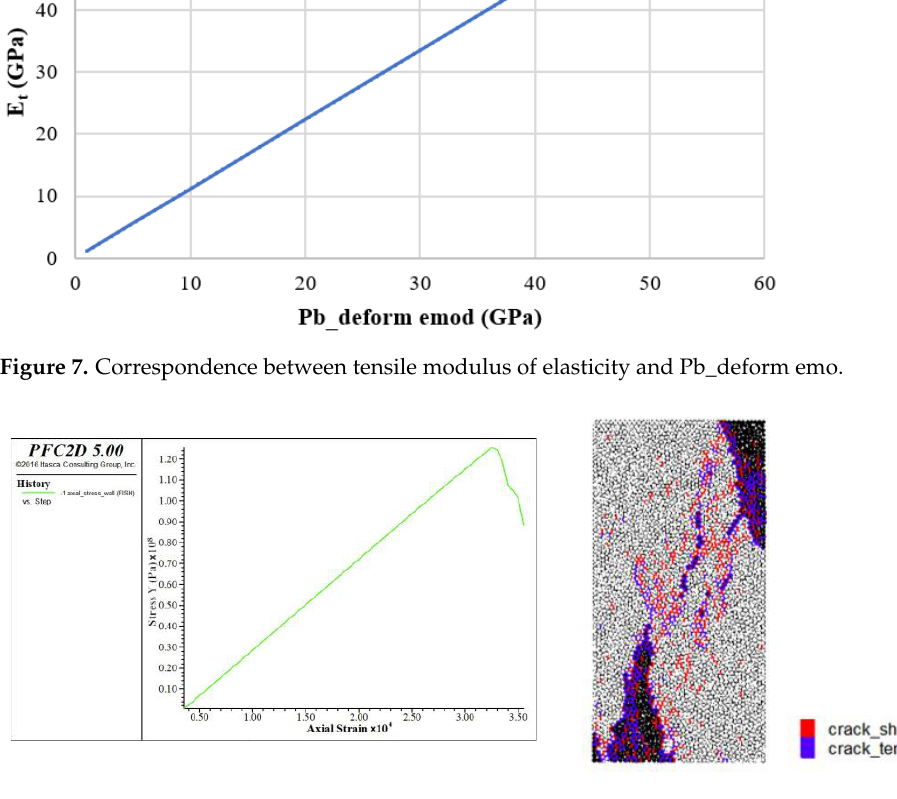
Figure 7. Correspondence between tensile modulus of elasticity and Pb_deform emo.